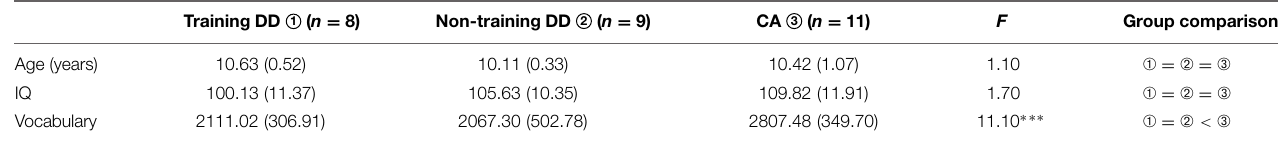
TABLE 1 | Characteristics of two developmental dyslexia (DD) groups and one chronological age-matched (CA)